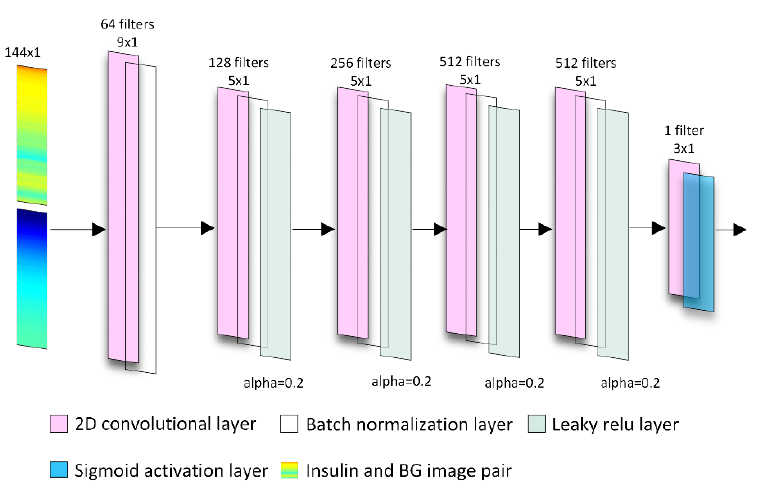
Figure 3. The patchGAN discriminator model that performs classification between real and generated BG images.